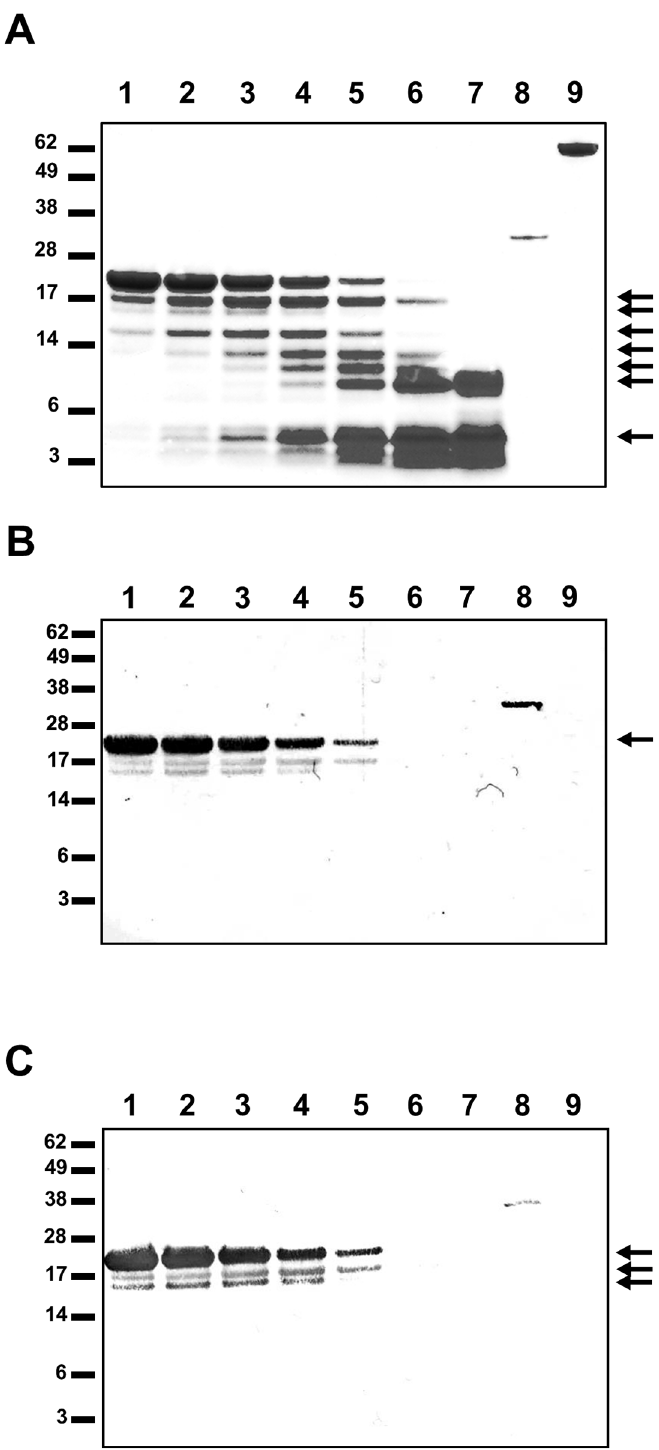
Fig 3. Endoproteinase cleavage of PilG 1-178 . (A) Endoproteinase-cleaved PilG 1-178 analyzed by SDS-PAGE and protein staining with Coomassie Blue. South-western assay of the cleavage products with DUS containing (B) ssDNA or (C) dsDNA. Protease incubation times are for lane 1, 15 min; lane 2, 30 min; lane 3, 1 h; lane 4, 2 h; lane 5, 4 h; lane 6, 8 h; lane 7, 24 h. Lane 8 contains Fpg and lane 9 contains BSA. The positions of the protein size standards (kDa) are shown on the left and the arrows indicate protein bands